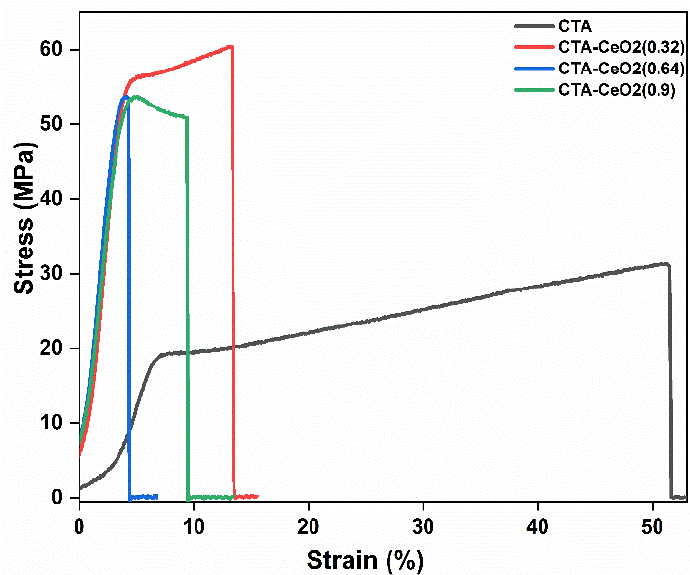
Figure 8. Tensile strength-elongation curves of the pristine and CeO 2 -modified CTA MMMs.